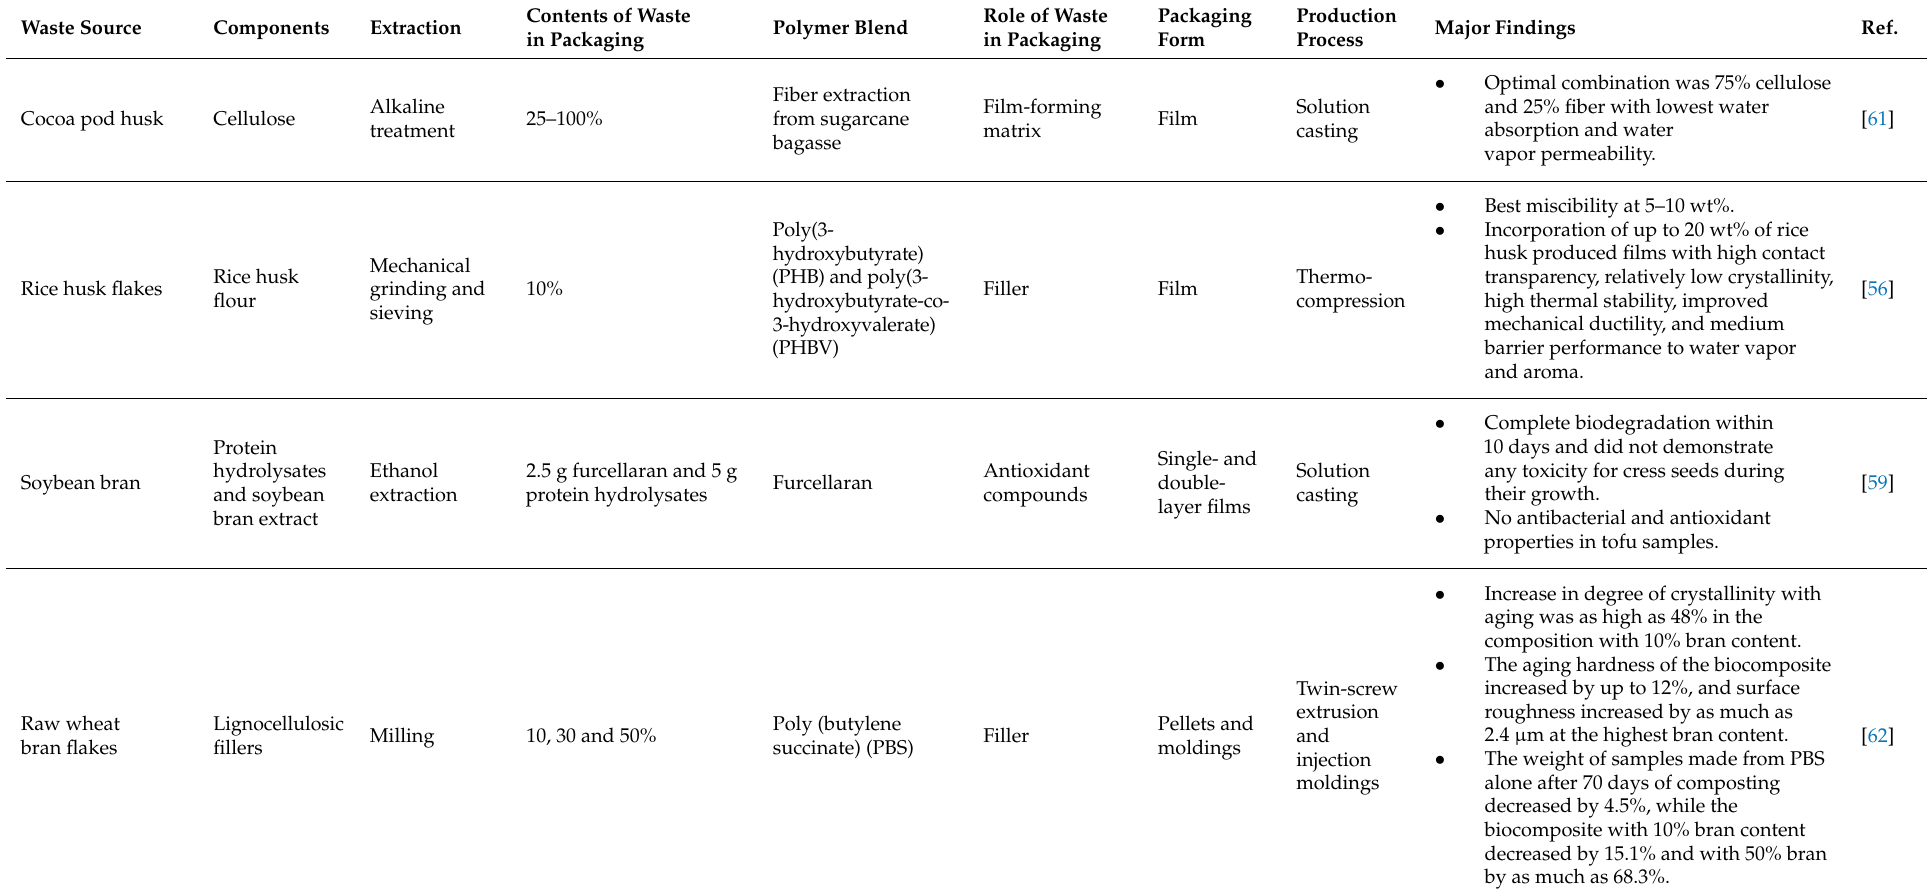
Table 3. Packaging utilizing process